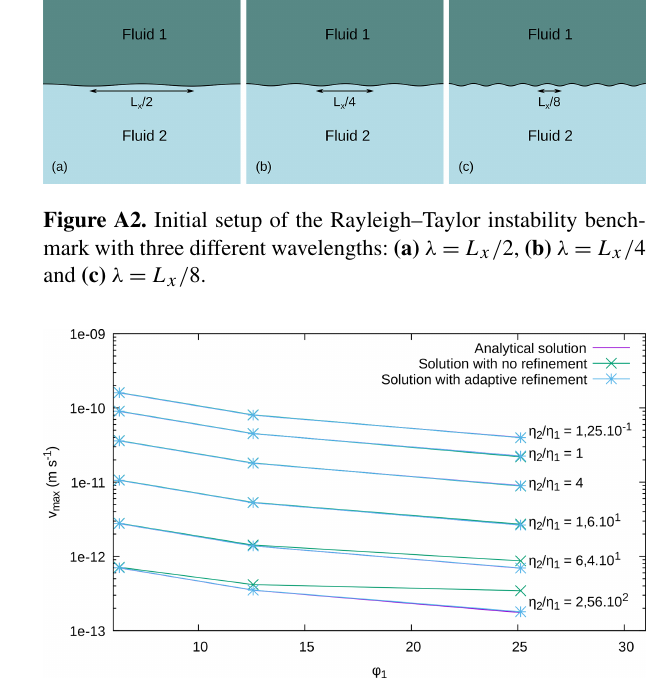
Figure A3. Comparison between numerical and analytical results for the Rayleigh–Taylor instability benchmark. The numerical re- sults are computed for a 80 × 80 element grid and for the same grid with three levels of adaptive